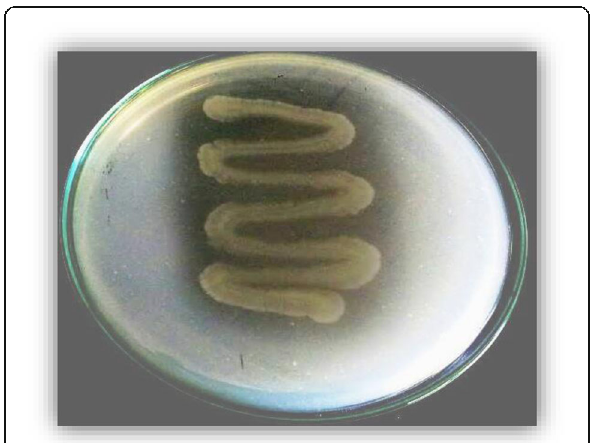
Fig. 1 Chitinase production by isolate A.S on nutrient agar containing 1.5% colloidal chitin incubated at 30 °C for 48 h. Presence of clear zone around the bacterial growth indicates chitin